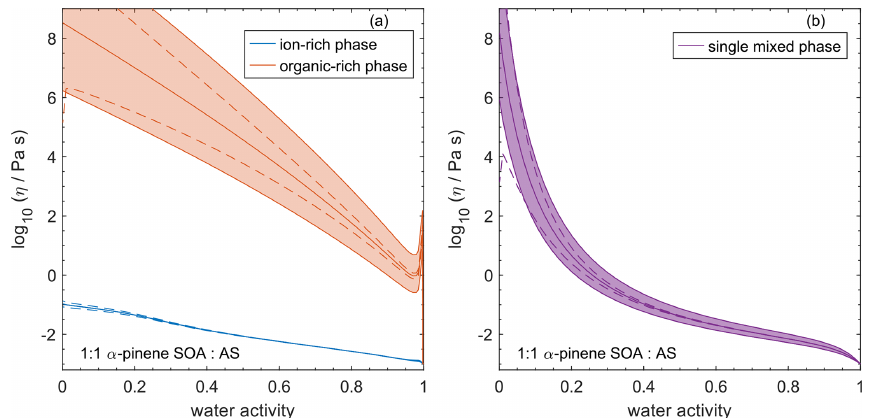
Figure 12. Viscosity predictions for aerosol surrogate mixtures containing α -pinene SOA and ammonium sulfate at varying water activity, a w (RH), with an overall organic-to-inorganic dry mass ratio (OIR) of 1 and T = 293 . 15K. (a) Viscosities of the individual coexisting liquid phases predicted by AIOMFAC LLPS model; blue: inorganic ion-rich phase; orange: organic-rich phase. (b) Predictions for a forced single mixed phase. The aquelec mixing model is used to calculate the viscosities of the organic–inorganic mixtures. Model sensitivity, defined by the impact of a ± 2% change in aerosol water mass, is shown by the dashed curves. Shaded regions show the potential viscosity prediction error introduced by a ± 5% error in the average glass transition temperature of the individual α -pinene SOA surrogate components.